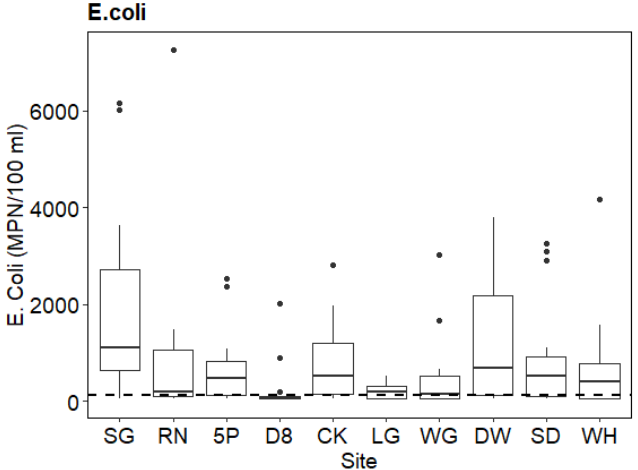
Figure 3. Boxplot results with the CDPHE standard for E. coli .